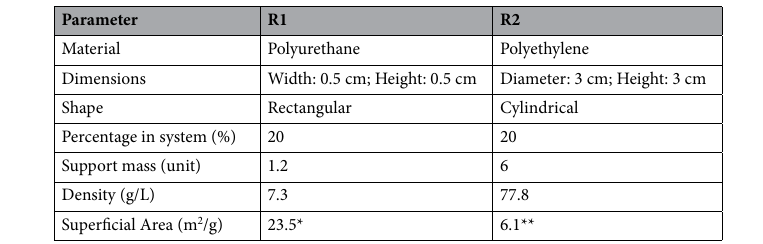
Table 1. Packing media characteristics. *Sahariah et al. 38 , **Silva et al. 51 .